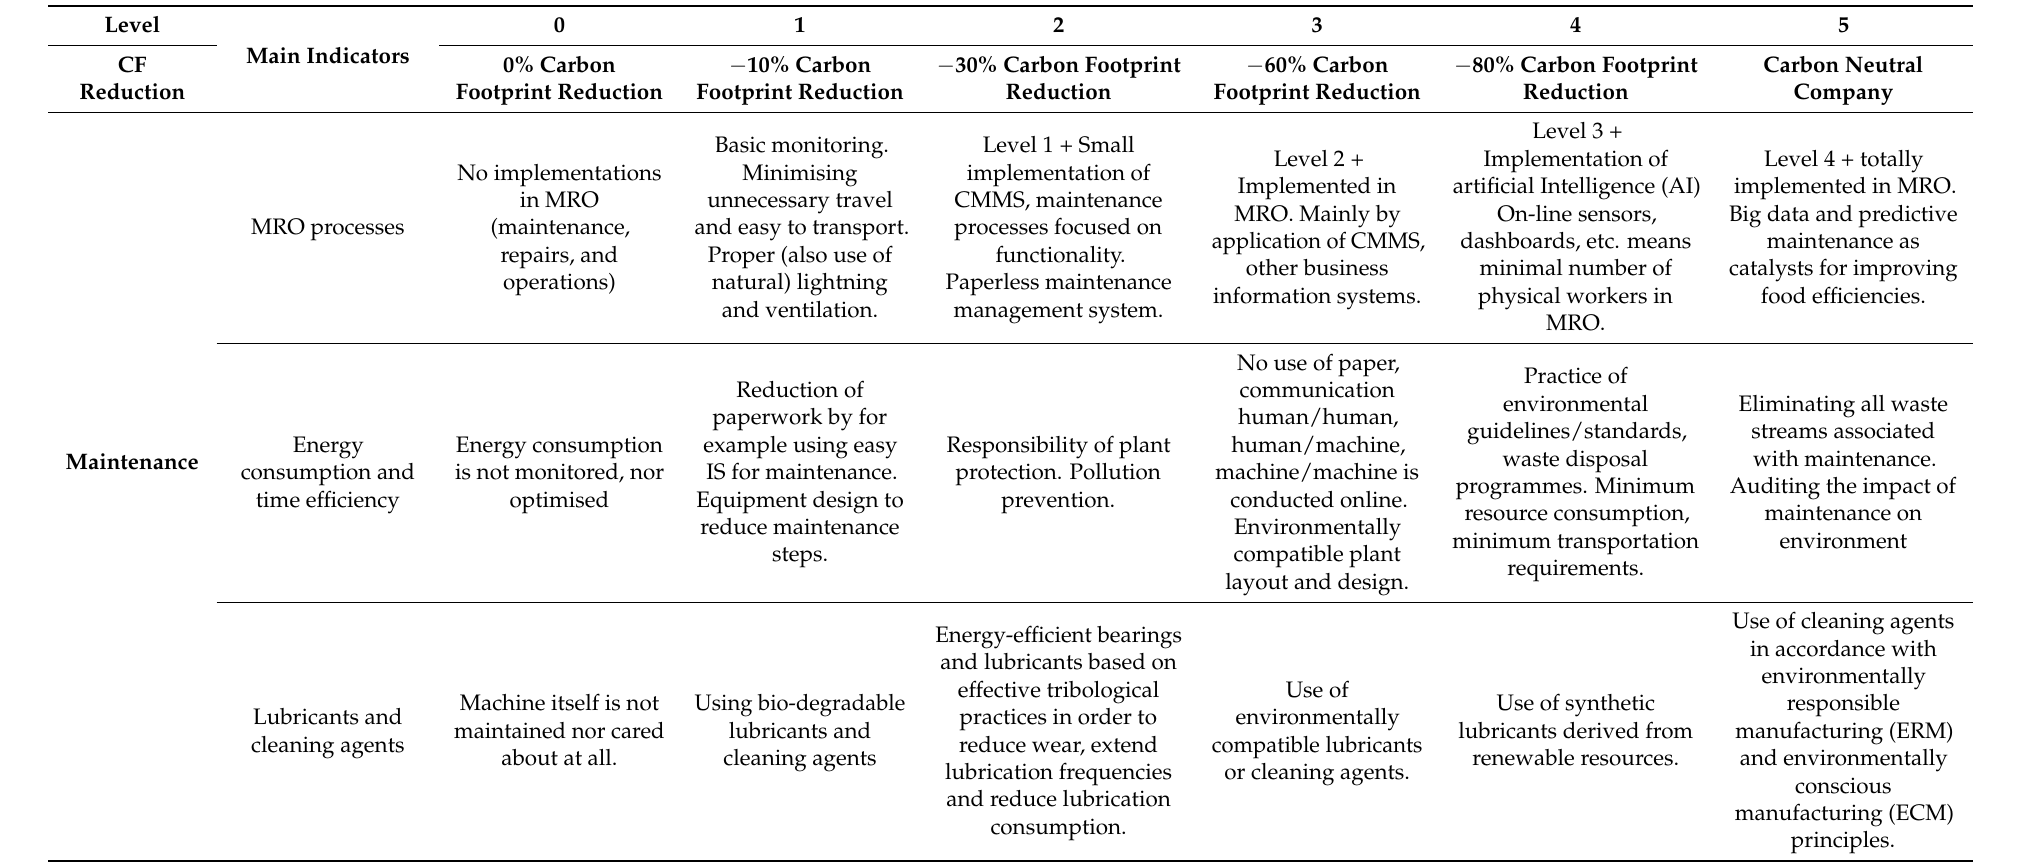
Table 6. Maintenance